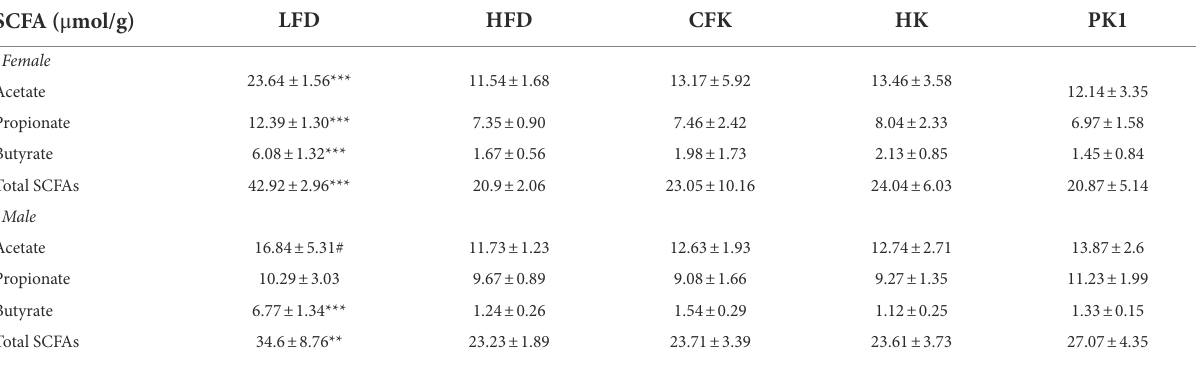
TABLE 1 Concentration of SCFAs ( μ mol/g) in cecal content of male and female C57Bl/6 mice fed a control diet or high-fat diet supplemented with milk or different kefir preparations for 8 weeks.